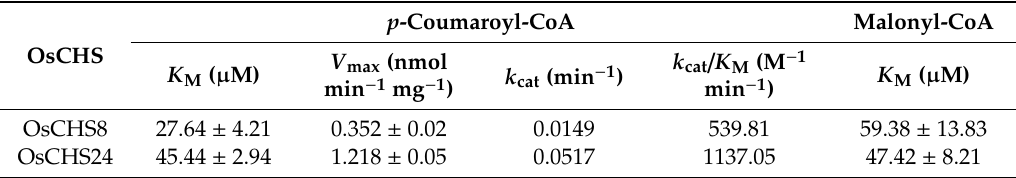
Figure 3. CHS activity assay of recombinant OsCHS8 ( a ) and OsCHS24 ( b ). The tetrahydroxychalcone was formed from p -coumaroyl-CoA and malonyl-CoA by OsCHS8 and OsCHS24. The resulting chalcone was spontaneously converted to naringenin, which was analyzed by reversed-phase HPLC. ( c ) HPLC chromatogram of the authentic naringenin.